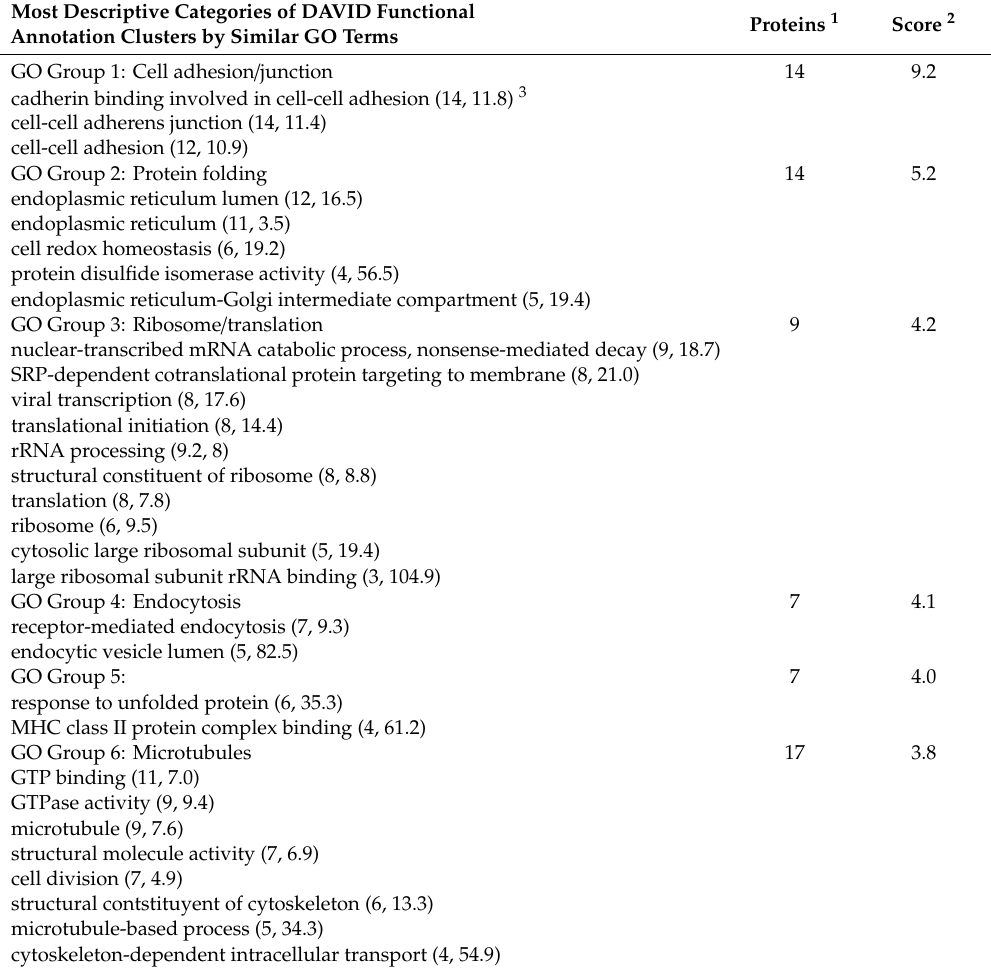
Table 4. DAVID functional annotation clustering for sperm-interacting proteins within oviductal fluid